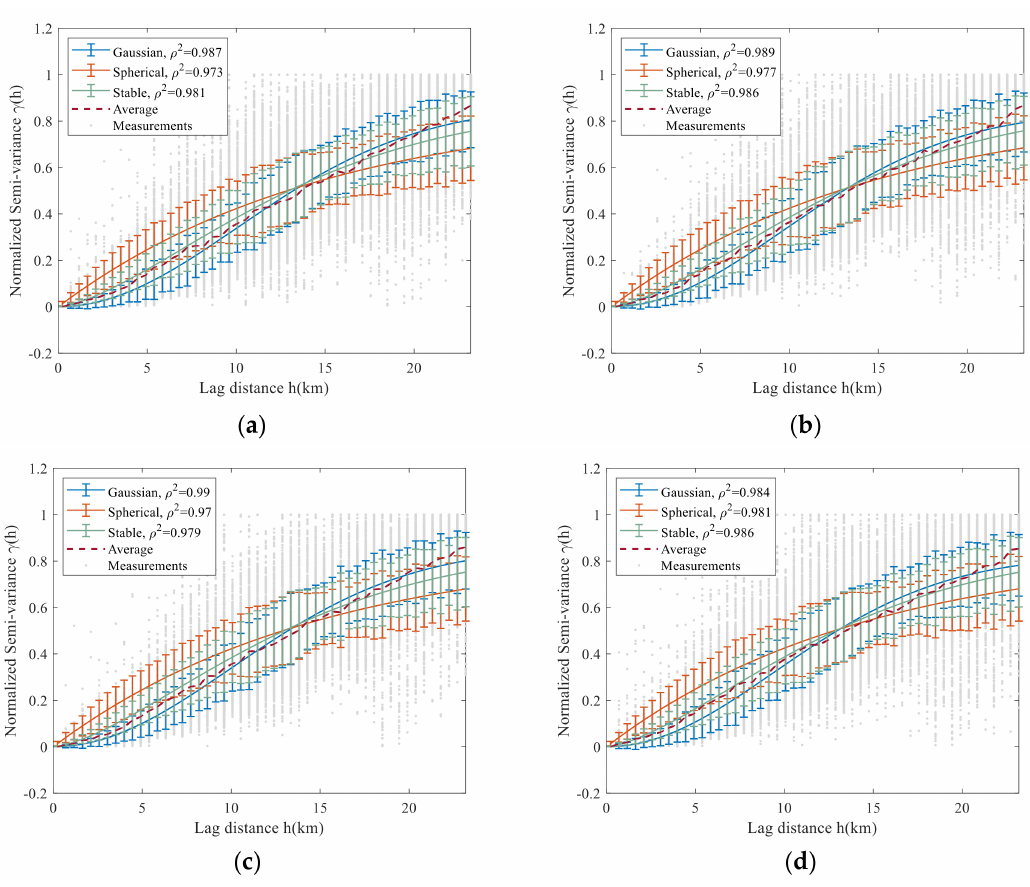
Figure 13. The data of normalized semi-variance measured by OELs network and corresponding variogram models in ( a ) 2016, ( b ) 2017, ( c ) 2018 and ( d ) 2019.